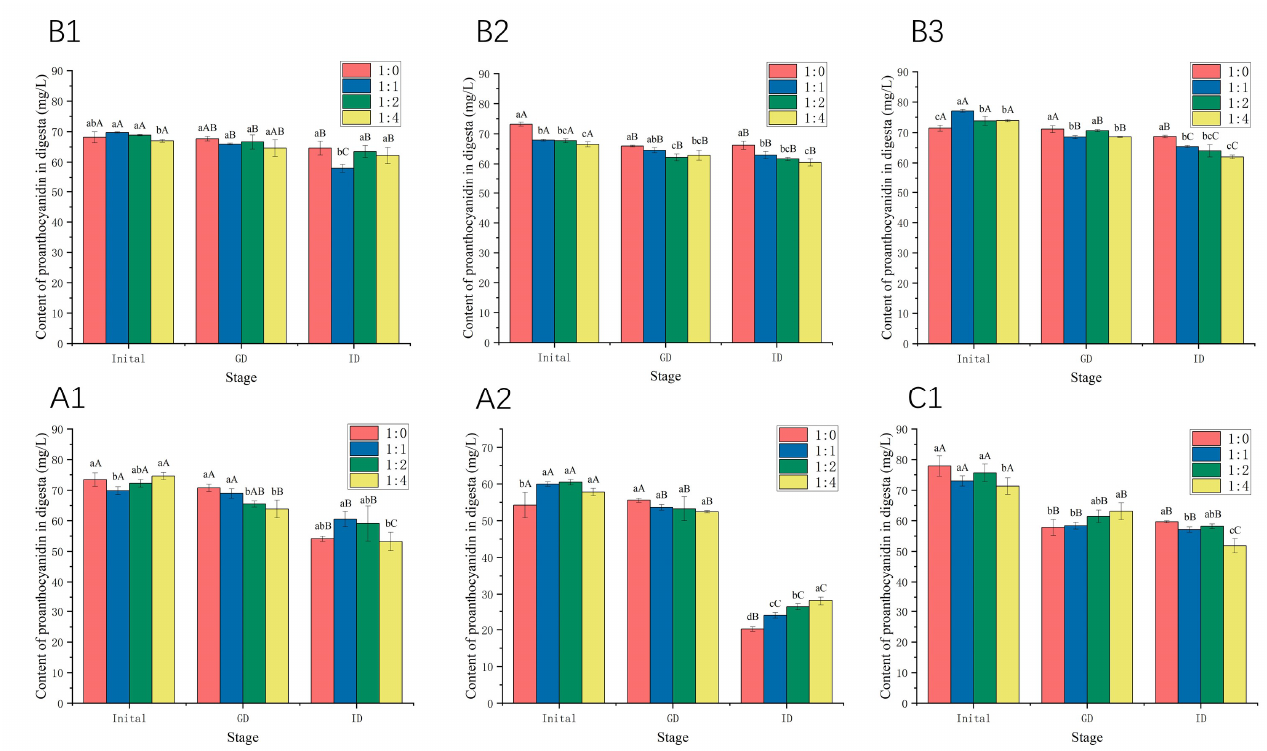
Figure 8. The stability of proanthocyanidin A1, A2, B1, B2, B3, and C1 with WPI at molar ratios of 1:0, 1:1, 1:2, and 1:4. GD: gastric-digested; ID: gastrointestinal-digested. Different lowercase letters indicate that there are significant differences in the same stage of samples at different molar ratios, p < 0.05. Different uppercase letters indicate that there are significant differences in the different stage of samples at the same molar ratio, p <